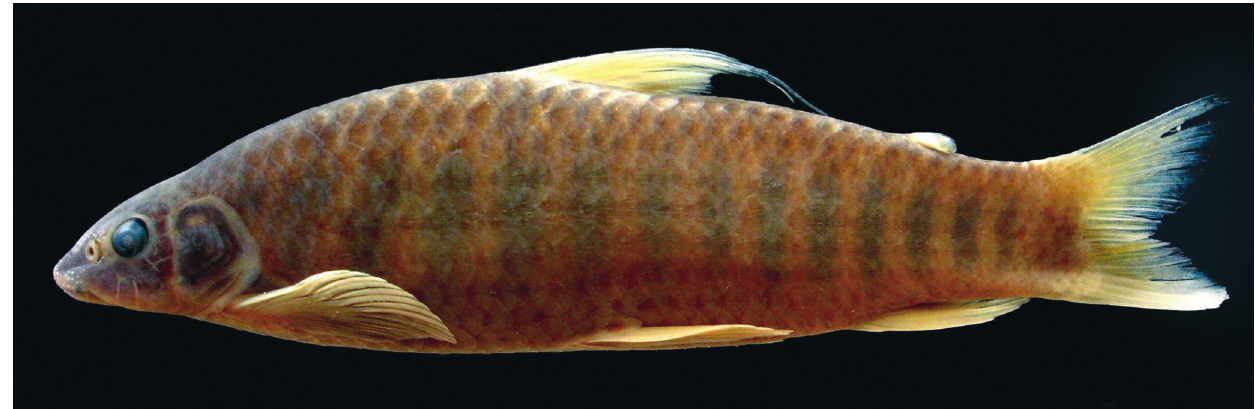
Fig. 3. Parodon apolinari , IAvH 3438; 101.9 mm SL. Colombia, Orinoco basin, Chiquito River at bridge on the Villao-Yopal